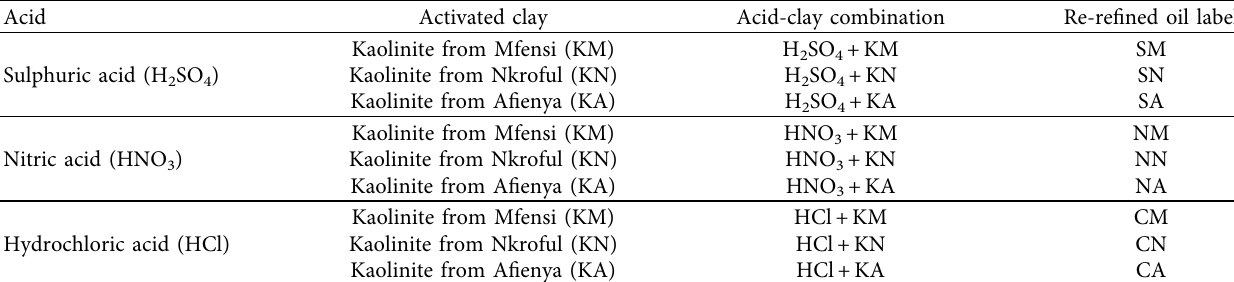
Table 1: Acid-clay combinations employed in this study for re-refning used engine oil.